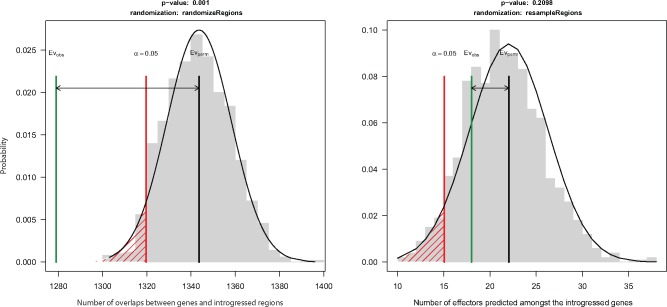
—Permutation test assessing possible associations in regions of the Zymoseptoria tritici genome showing signatures of introgression. On the left, association with predicted genes. On the right, association with predicted effectors among the genes overlapping with signatures of introgression. In gray, the random distribution obtained from 1,000 randomizations. The black line represents the median random value, the green line the observed value and the red line the threshold of significance (here, set at 0.05).